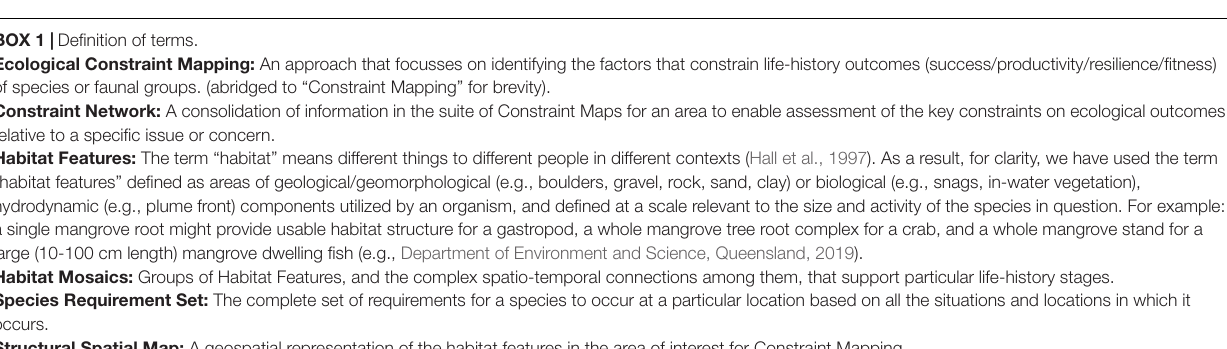
FIGURE 1 | The relationship between Ecological Constraint Mapping and a whole-of-system catchment management framework. Left-hand side : Wetlands in the Great Barrier Reef Catchment: Management Strategy 2016–21, (modified from QldDEHP, 2016): Right-hand side : relationships to Constraint Mapping.